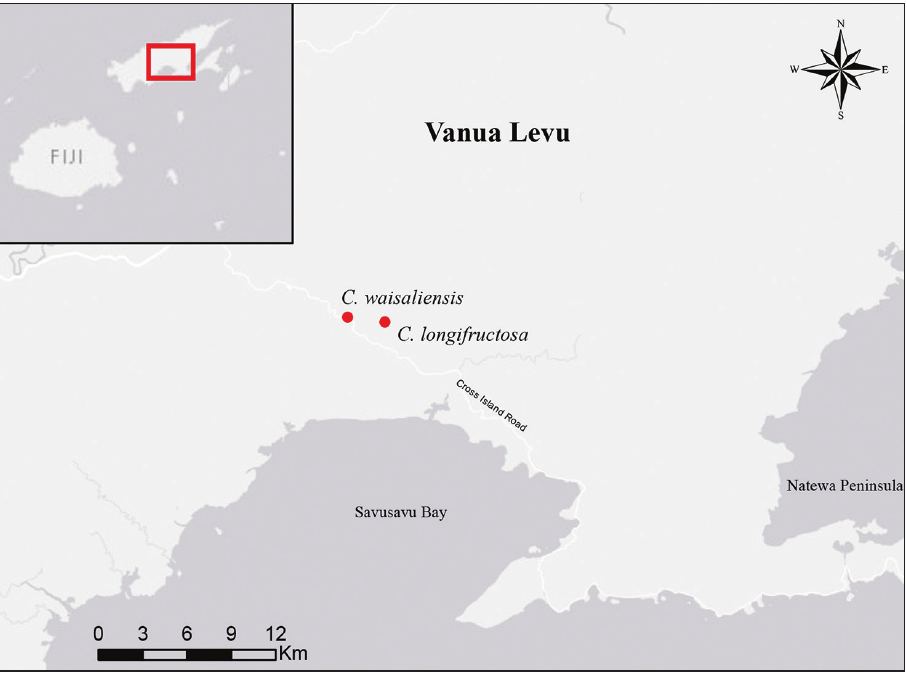
Figure 9. Distribution of Cyrtandra waisaliensis and C. longifructosa on Vanua Levu,